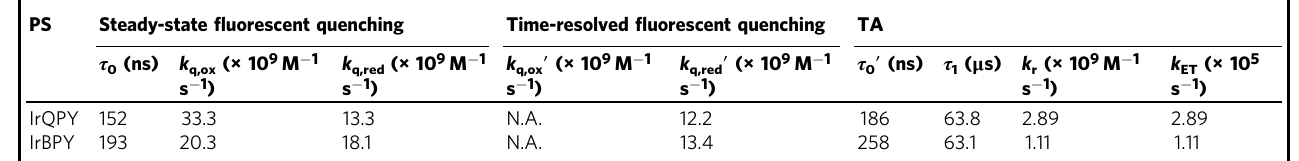
Table 2 Related data and calculated reaction constants from steady-state/time-resolved fl uorescent quenching and TA experiments in degassed CH 3